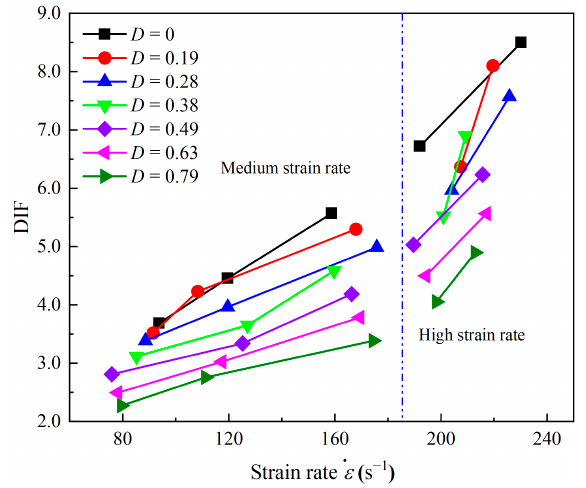
Figure 18. Dynamic increase factor (DIF) of dynamic compressive strength.